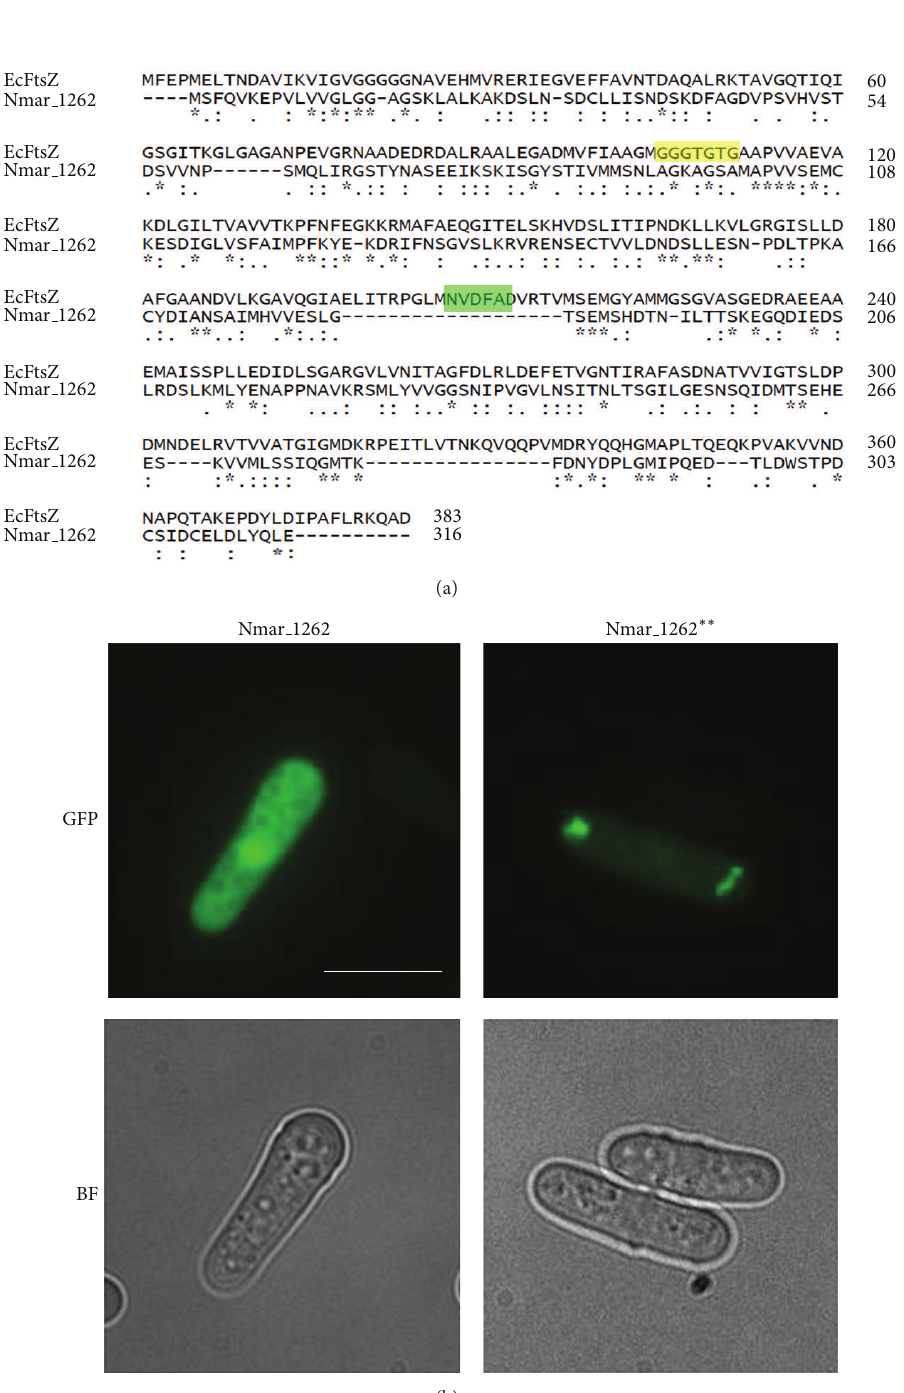
Figure 4: N. maritimus FtsZ-GFP (Nmar 1262) does not form filament-like structures in yeast. (a) Sequence alignment of the Nmar 1262 with the E. coli FtsZ (EcFtsZ). Regions highlighted in yellow and green in the EcFtsZ sequence are two conserved motifs for tubulin/FtsZ, GGGTGTG, and NVDFAD (T7-loop) for GTP binding and hydrolysis, respectively. Sequence alignment was performed using ClustalW2 program available from the website http://www.ebi.ac.uk/Tools/msa/clustalw2/. (b) Images of yeast cells expressing Nmar 1262-GFP